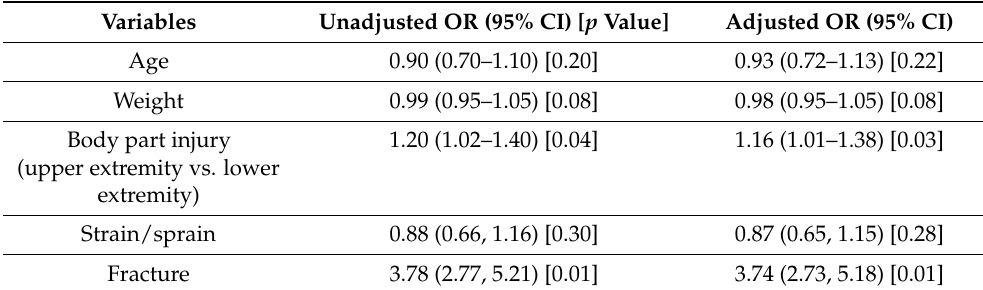
Table 2. Odds ratios for injuries in in gymnastics compared to dancing